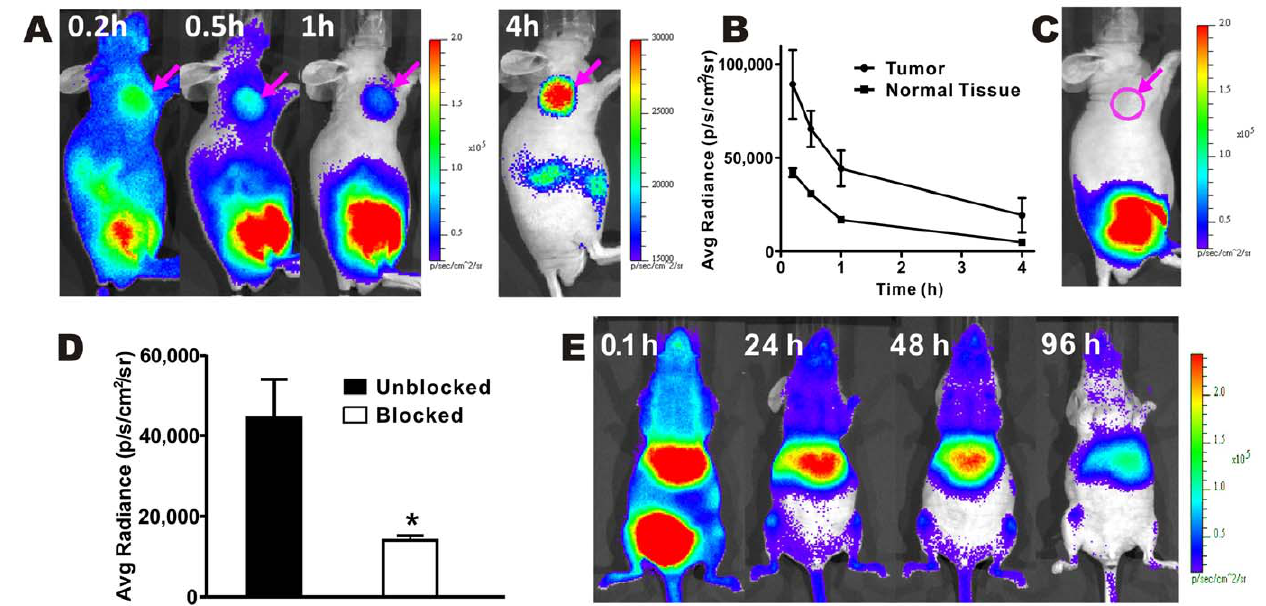
Figure 6. Invivo radioactive OI of 90 Y-RGD-BBN and 90 YCl 3 . Radioactive OI ( A ) and quantitative analysis (n=3) ( B ) of 90 Y-RGD-BBN in mice bearing PC3 tumor. ( C,D ) Receptor blocking studies of 90 Y-RGD-BBN probe (at 1 h post-injection) using radioactive OI ( C ) and their quantification analysis (n=3) ( D ). ( E ) Radioactive OI of 90 YCl 3 at various time points p.i.